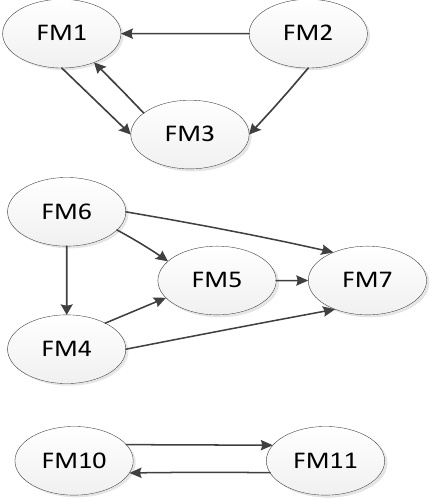
Figure 5. The causal diagram of total relation (k >